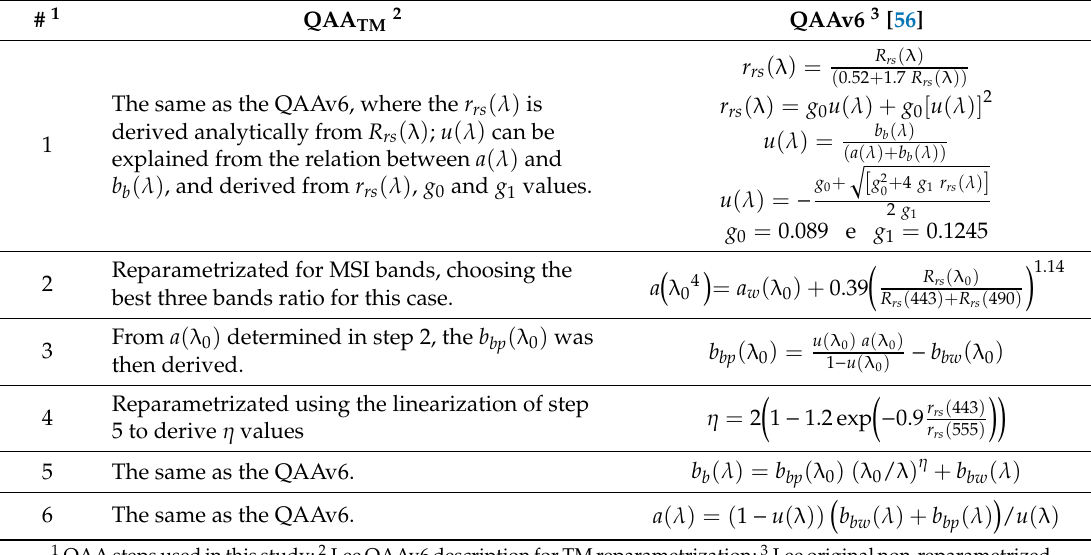
Table 3. Summary of QAA TM Description and original QAAv6